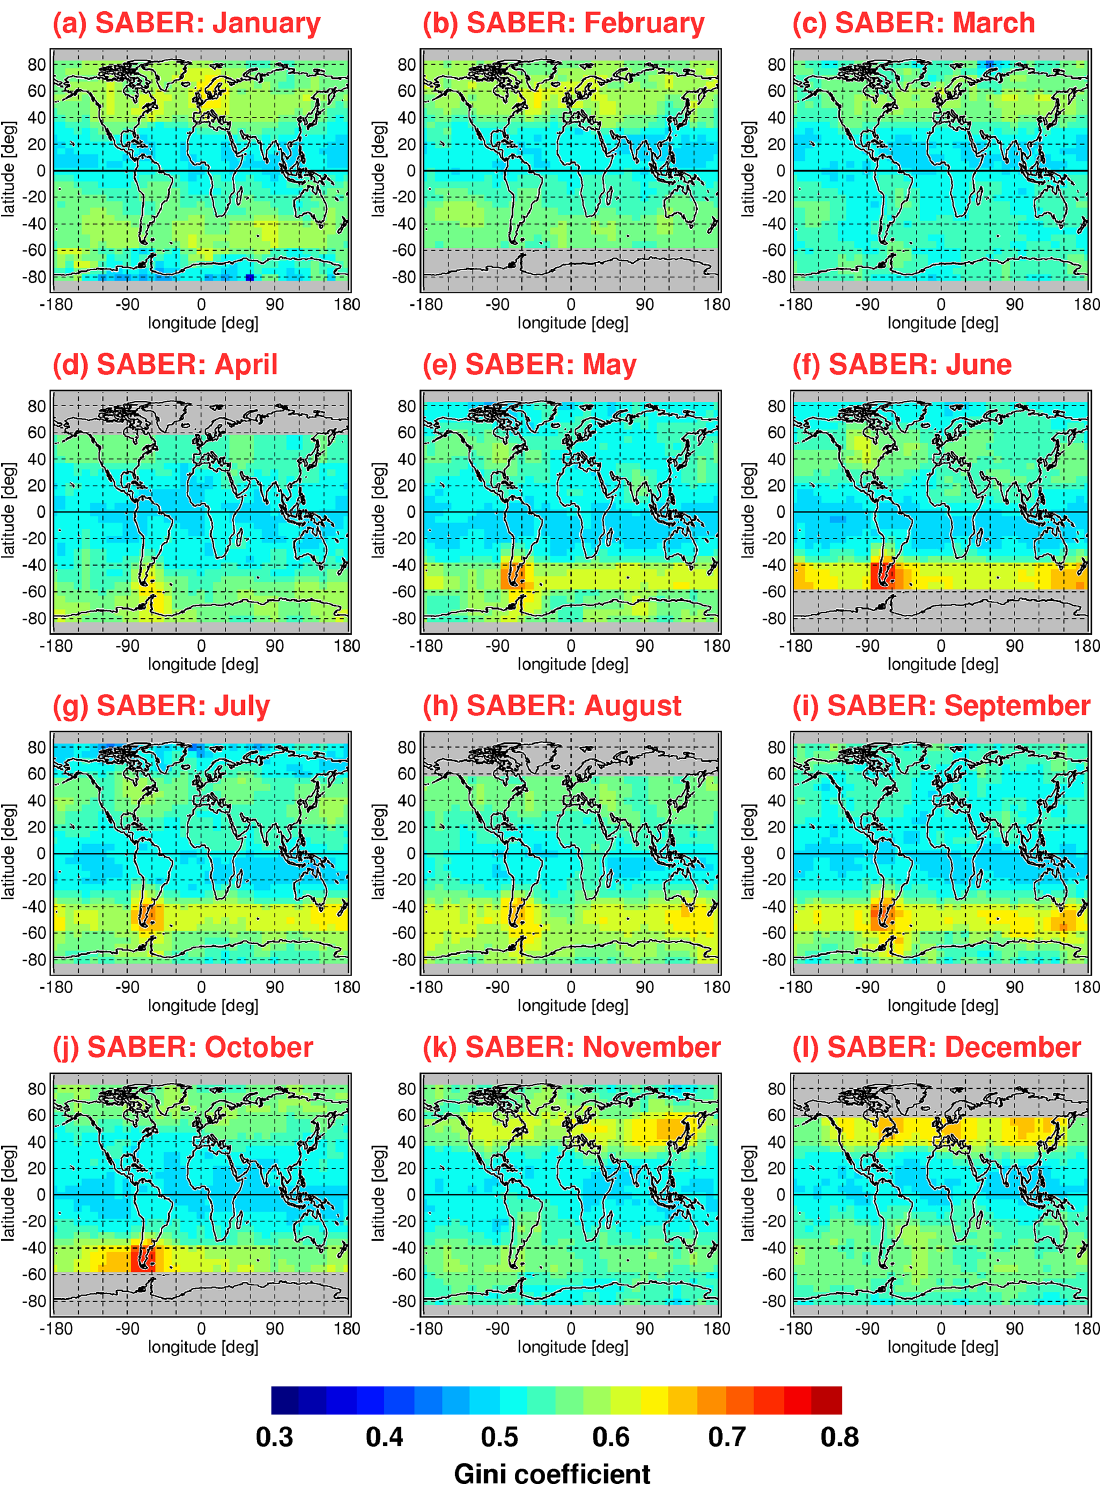
Figure 14. Same as Fig. 12 but for the Gini coefficients for SABER gravity wave absolute momentum fluxes and using a larger bin size of 20 ◦ × 30 ◦ (latitude ×